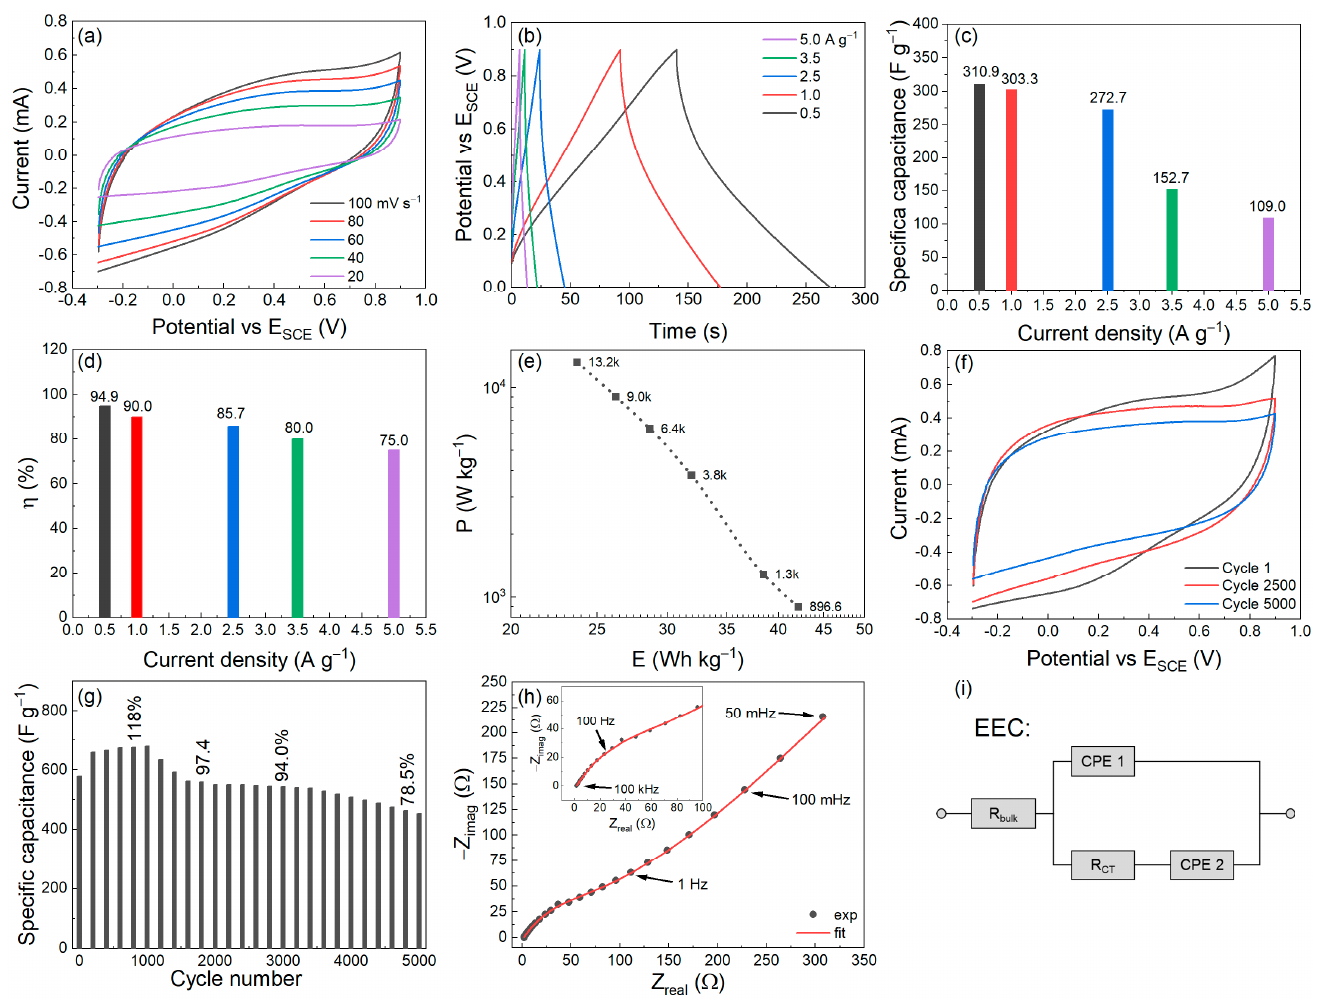
Figure 6. ( a ) CVs of PNZ in two-electrode setup at different scan rates (20 to 100 mV s − 1 ) in a potential range between -0.3 V and 0.9 V, ( b ) GCD of PNZ at different current densities (0.5 to 5.0 A g − 1 ) in the same potential range, ( c ) calculated specific capacitances of PNZ at the different current densities, ( d ) coulombic efficiencies of PNZ at the different current densities, ( e ) Ragoné plot of PNZ, ( f ) CVs of PNZ at a scan rate of 100 mV s − 1 after aging in a potential range between -0.3 V and 0.9 V, ( g ) cycle stability of PNZ at 100 mV s − 1 over 5000 cycles, ( h ) EIS spectra of PNZ in two-electrode setup at V DC = 200 mV in the frequency range of 100 kHz to 50 mHz, ( i ) electrical equivalent circuit used for EIS fitting. (The mass of polymer was 0.2 mg for all fabricated electrodes, and all CV, GCD, and EIS plots were recorded in 1.0 M H 2 SO 4 aqueous solution).